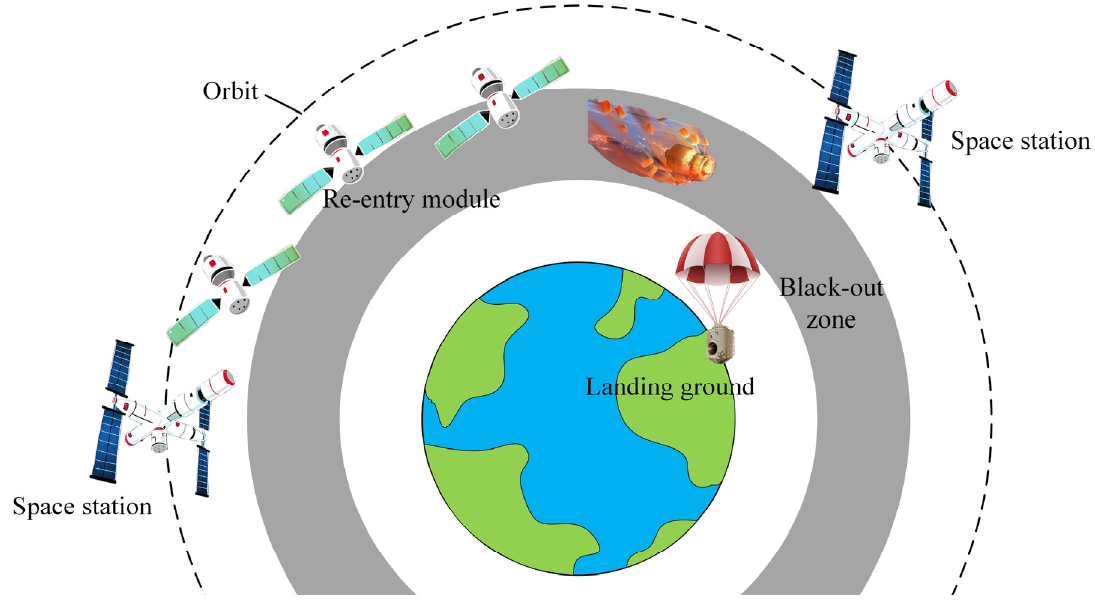
Figure 1. The return process of Shenzhou XII